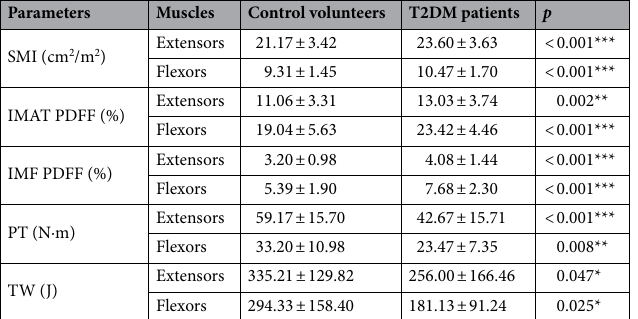
Table 3. Differences in MRI parameters and isokinetic muscle strength measurements of thigh muscles between volunteers without T2DM and T2DM patients ( x ± s). SMI skeletal muscle index, PDFF proton density fat fraction, PT peak torque, TW total work. * p < 0.05; ** p < 0.01; *** p <